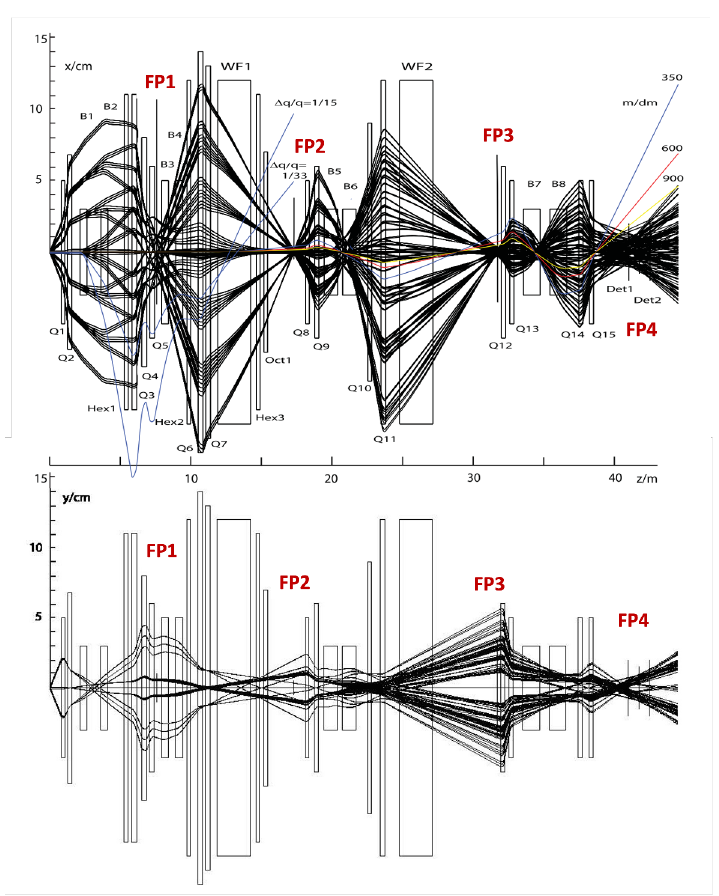
Figure 2. The ion optics of SECAR for the layout shown in Figure 1 is corrected up to the 4 th order. The characteristic rays in the horizontal and vertical plane are shown in the upper and lower panel, respectively. The mass resolution in the horizontal plane at FP2 is m /∆ m = 510 and at FP3, m /∆ m = 780. The picture was obtained from G.P.A. Berg et al., Nuclear Inst. and Meth. in Phys. Res. A, 877, 87–103